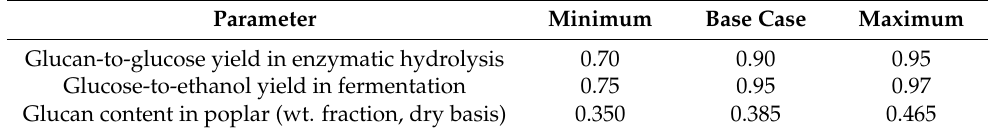
Table 3. Triangular distribution parameters for random variables used in the Monte Carlo analysis. Parameter Minimum Base Case Maximum Glucan-to-glucose yield in enzymatic hydrolysis Glucose-to-ethanol yield in fermentation Glucan content in poplar (wt. fraction, dry